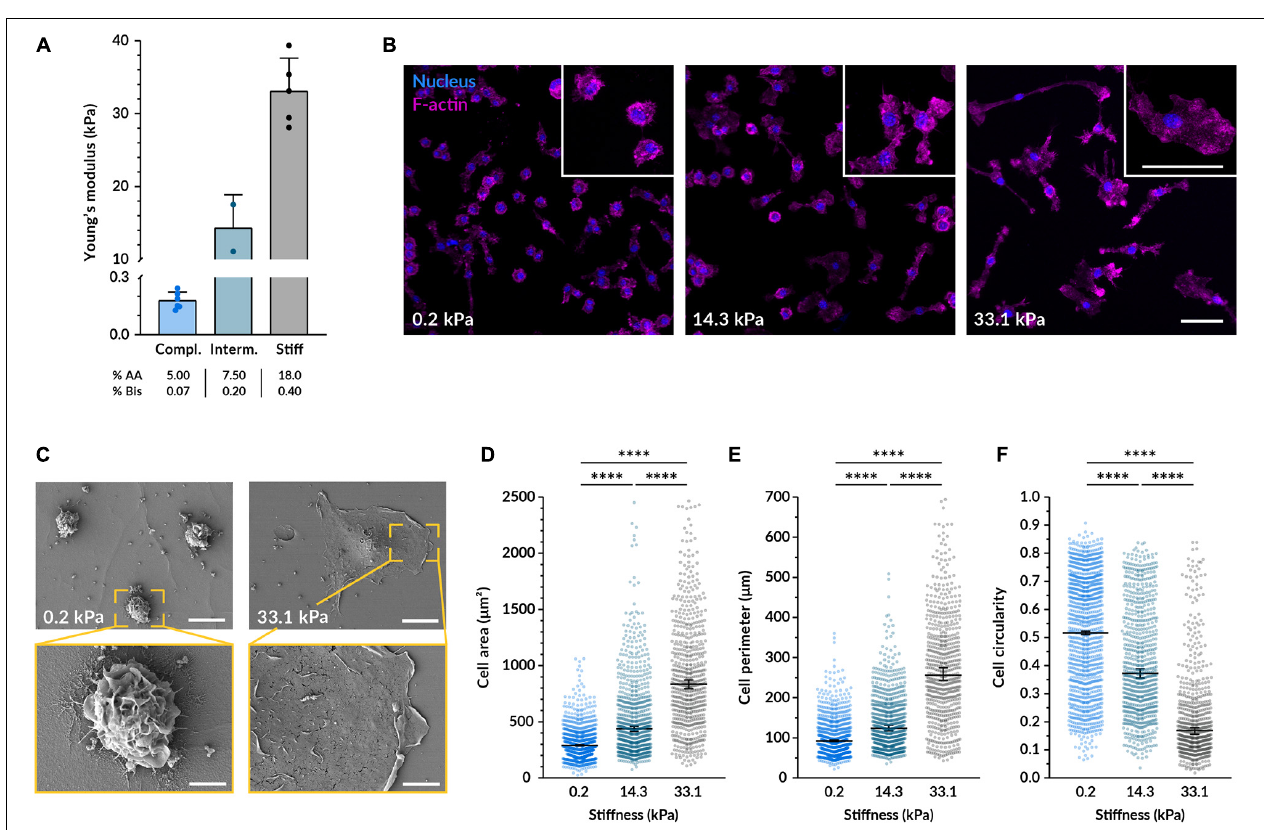
FIGURE 1 | Substrate stiffness affects the morphology of macrophages. (A) Young’s moduli of the three different polyacrylamide 2D hydrogels used as cell substrate obtained by AFM. The mean ± SD was 0.18 ± 0.04 kPa for the compliant, 14.32 ± 4.54 kPa for the intermediate, and 33.07 ± 4.55 kPa for the stiff gel. (B) Representative confocal microscopy images of fluorescent BMDMs cultured on the different gels for 14–18 h. Nuclei shown in blue (DAPI) and F-actin in magenta (phalloidin-TRITC). Enlarged examples of cells of each condition are displayed in the insets. Scale bars, 50 µ m. (C) Scanning electron micrographs of BMDMs on the compliant and stiff gels cultured as in (B) . Scale bars on top, 50 µ m, and bottom, 20 µ m. (D–F) Quantification of the cell area (D) , perimeter (E) , and circularity (F) from images taken under the same conditions as (B) . In all plots, each dot represents a cell and the black bars indicate mean ± SEM. The number of analyzed cells was 1117 for compliant, 771 for intermediate and 629 for stiff; data were obtained from 3 independent experiments done with cells from three different mice. Statistical analysis was performed using a Kruskal–Wallis ANOVA followed by Dunn’s post hoc analysis to obtain the multiple comparison p -values. ∗∗∗∗ p <